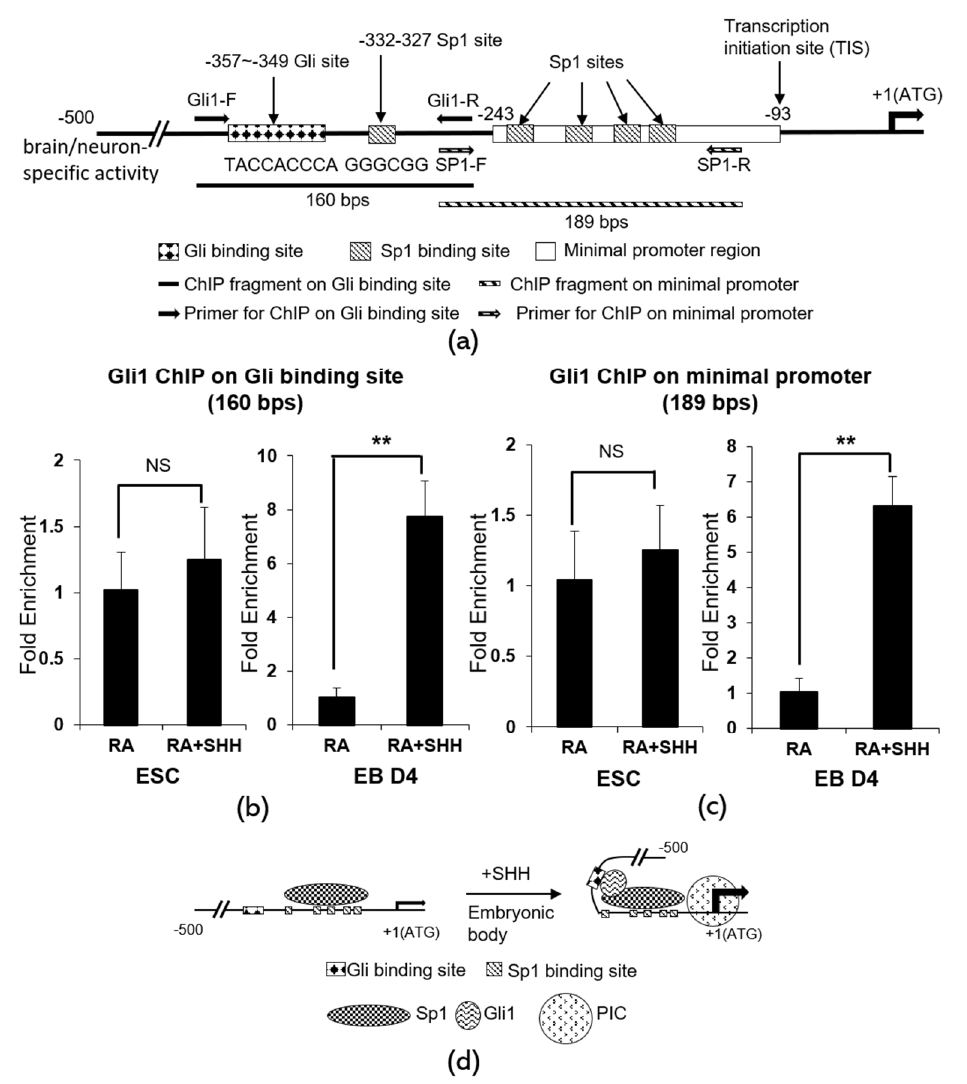
Figure 4. ChIP assays for Shh activated Gli-induced chromatin conformational change on the Crabp1 promoter. ( a ) The map of neuron-specific promoter of Crabp1 gene and the design of ChIP assays. Gli1-F, forward primer for the Gli site-containing fragment; Gli1-R, reverse primer for the Gli site-containing fragment; SP1-F, forward primer for the minimal promoter fragment; SP1-R, reverse primer for minimal promoter fragment. The Gli-binding chromatin is indicated by 160 bps PCR fragment. The minimal promoter containing Sp1 sites is indicated by 189 bps PCR fragment. ( b ) ChIP results of Gli1 physical association with the Gli binding site (160 bps fragment) in embryo body (EB D4, right) vs. embryonic stem cells (ESC, left). ( c ) ChIP results of Gli physical association with the minimal promoter (189 bps fragment) in embryo body (EB D4, right) vs. embryonic stem cells (ESC, left). Results are presented as means ± SD; * p < 0.05, ** p < 0.01; compared RA+Shh to RA only group; NS, not significant. ( d ) A molecular model depicting Shh activation of Gli1-induced chromatin juxtaposition of the Gli-binding region with the Sp1-binding minimal promoter of Crabp1 gene. Change in this chromatin conformation brings the Gli1/Sp1 activator complex to the proximity of preinitiation complex (PIC), thereby facilitating transcription activation.